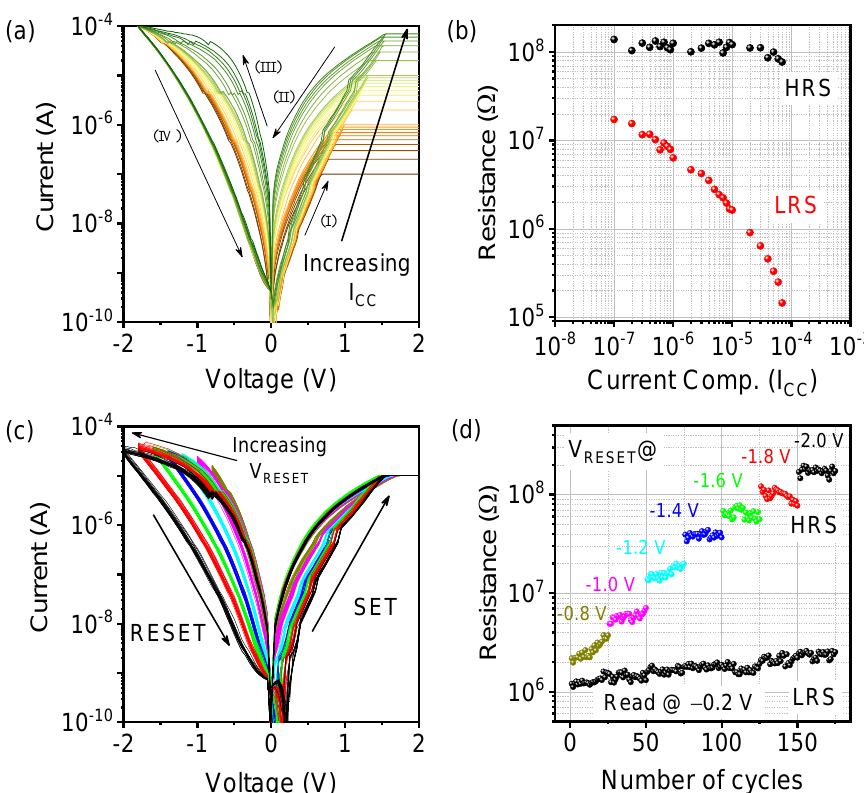
Figure 2. ( a ) Increasing LRS behavior of the ITO/WO x /TaO x /TiN memristor device by varying the SET current compliance from 1 × 10 ‒7 A to 7 × 10 ‒5 A. ( b ) Variations of multiple LRSs at each current compliance from 17.2 MΩ to 0.15 MΩ. ( c ) Multilevel memory state achieved by increasing V RESET from ‒0.8 V to ‒2.0 V at the current compliance of 1 × 10 ‒5 A. ( d ) Endurance characteristics of 7 HRSs under different V RESET values where the I ON /I OFF ratio increases gradually from 2.2 to 73.8.